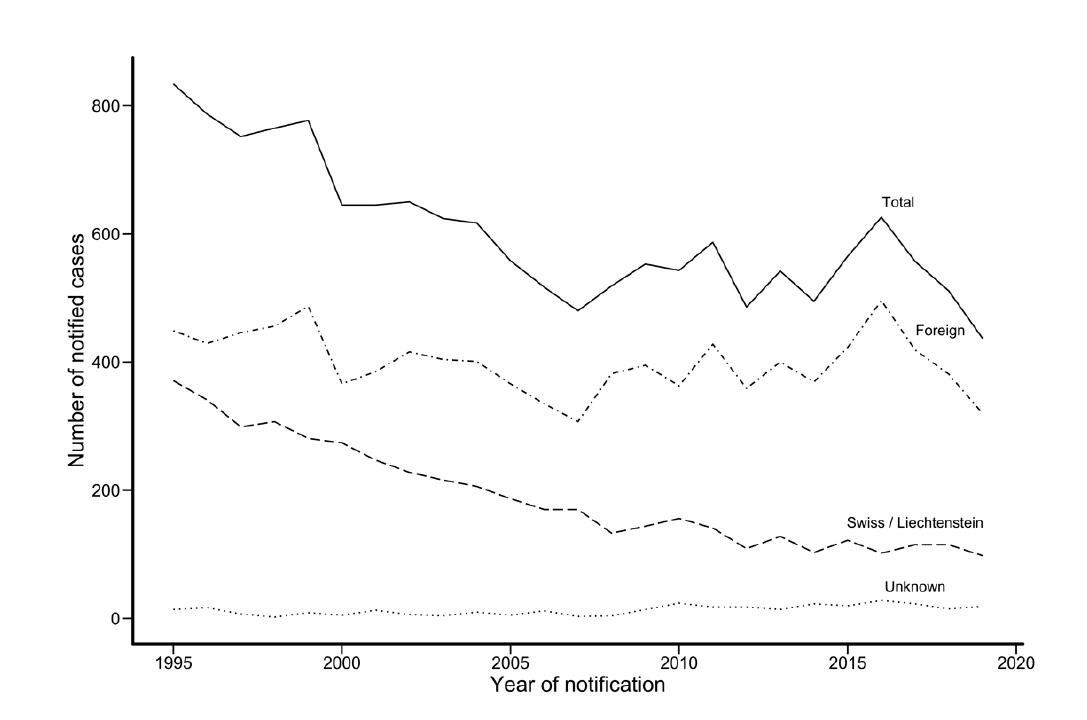
Figure S1: Annual numbers of tuberculosis, by origin, in Switzerland and Liechtenstein 1995–2019. The Swiss case definition for tuberculosis is met if laboratory or clinical criteria are met. For details see ‘Materials and